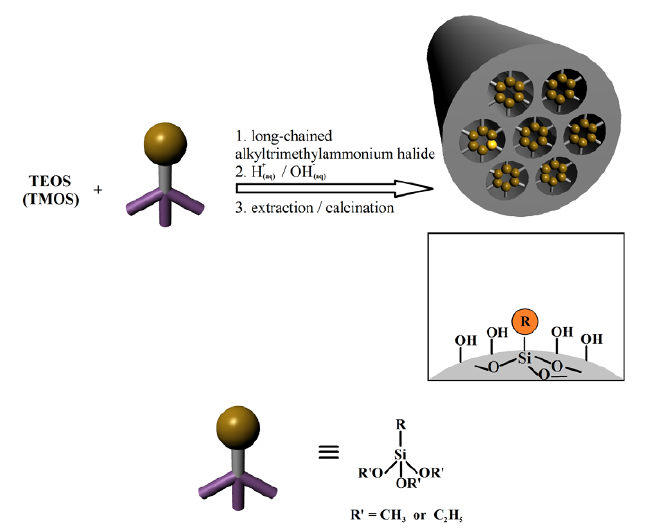
Figure 2. Co-condensation as one of the methods for the modification of mesoporous silica.